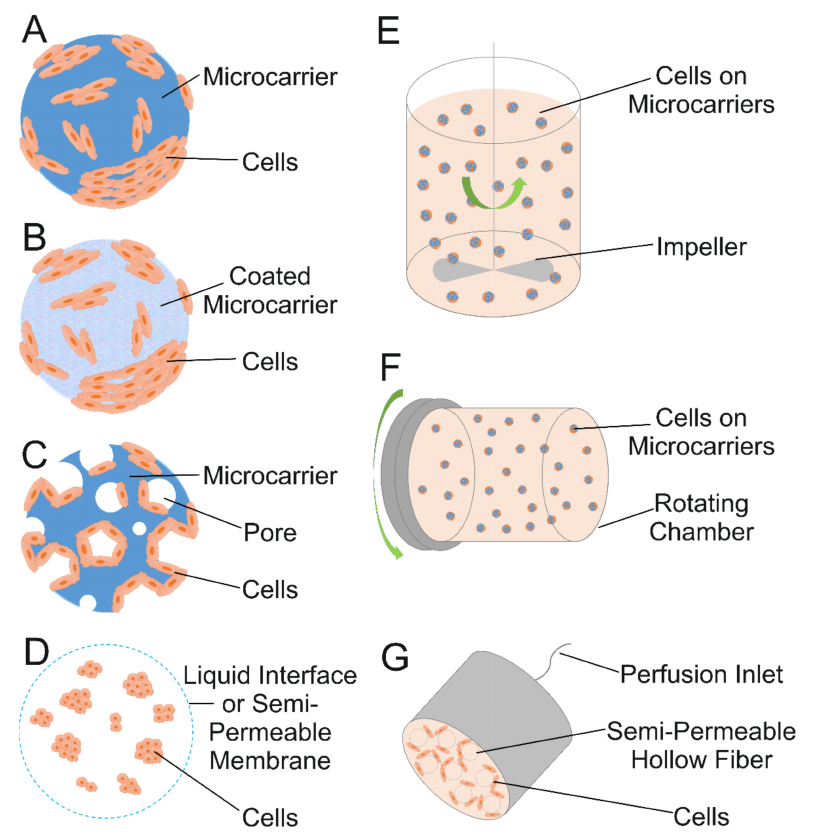
Figure 5. Schematics showing culture of cells on microspheres and in bioreactors. ( A ) Solid microcar- rier with cells growing on the surface. ( B ) Microcarrier coated to promote cell attachment. ( C ) Porous microcarrier, with cells growing in pores. ( D ) Cells encapsulated in liquid microspheres. ( E ) Stirred- tank bioreactor. ( F ) Rotating flask bioreactor. ( G ) Perfused hollow fiber bioreactor. Schematics based on